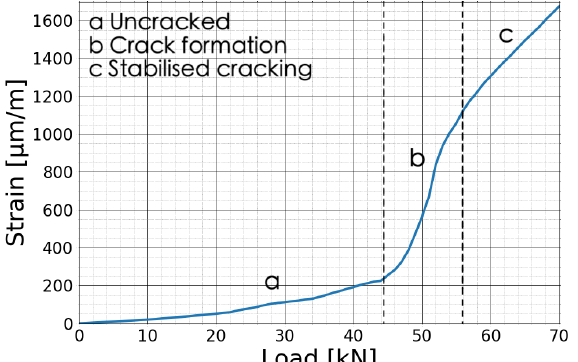
Figure 11. Force-strain curve of crack 5 measured by fiber line